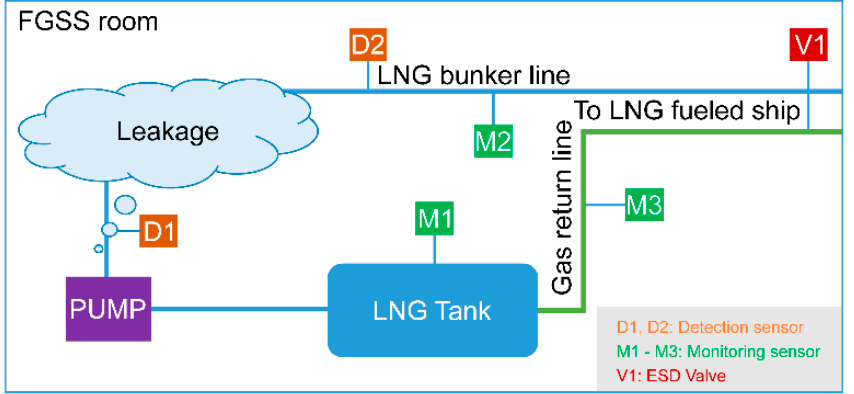
Figure 8. Liquefied natural gas (LNG) bunkering accident